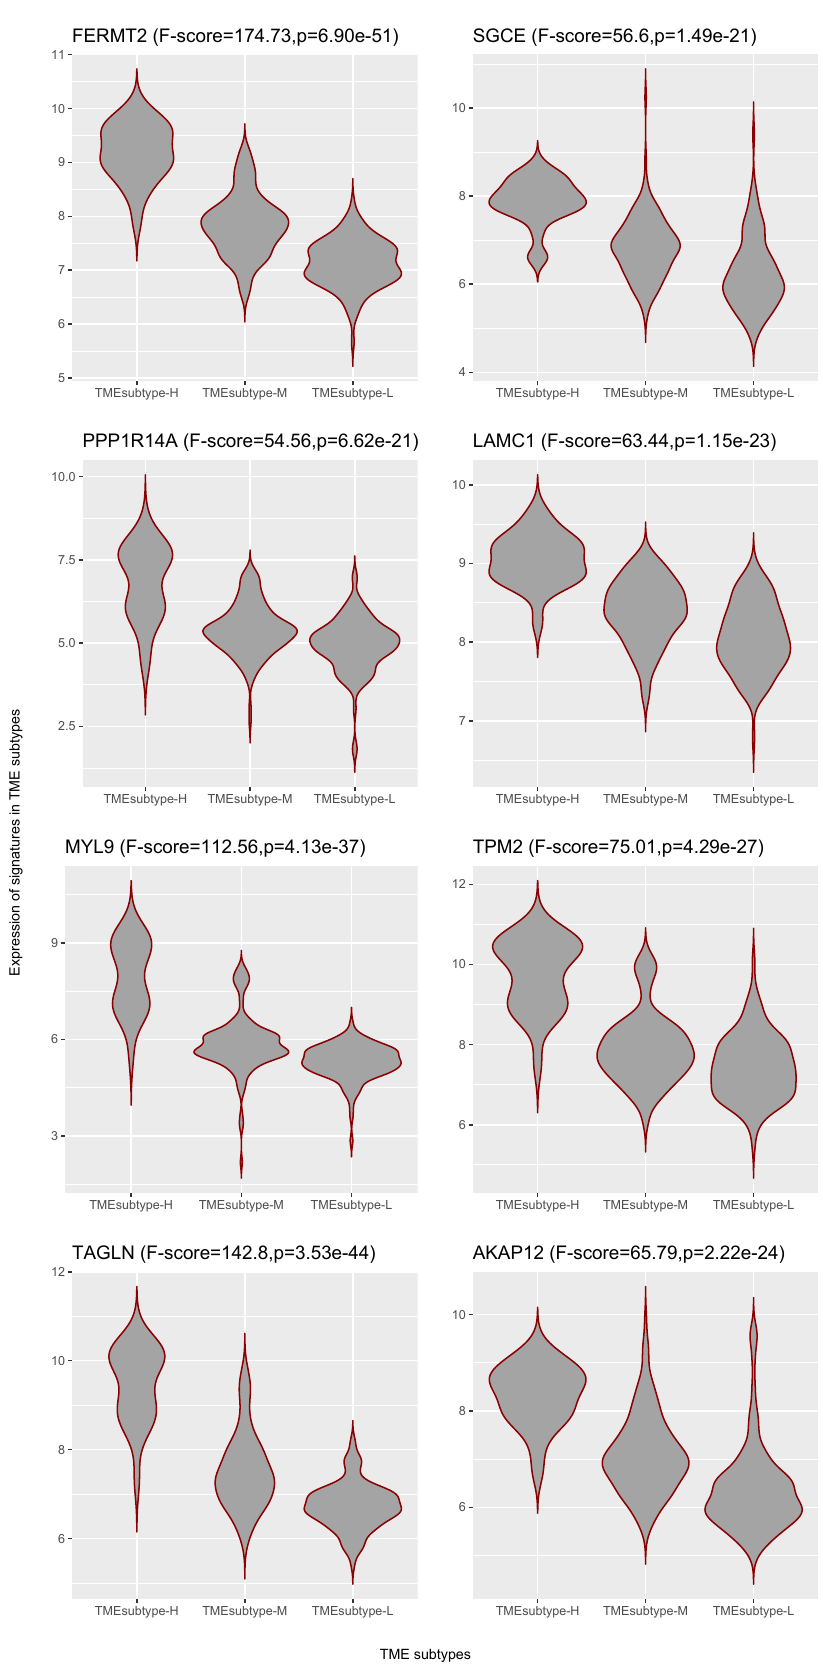
Figure 22. Violin plots showing differential expression of representative stromal cell markers in three TME